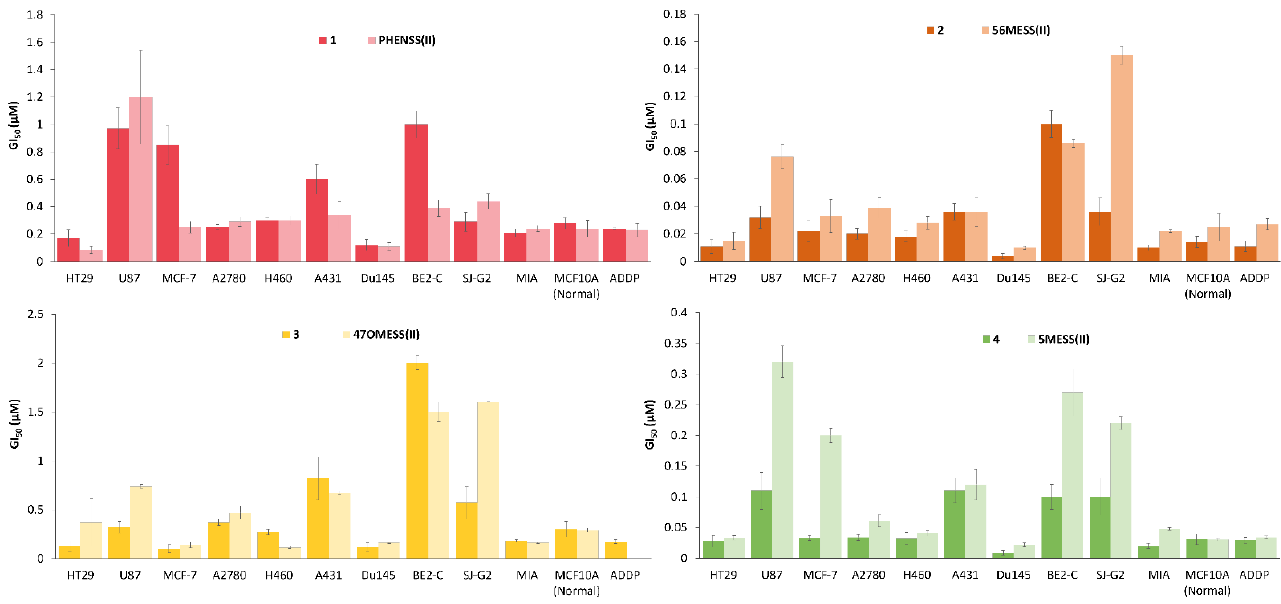
Figure 10. The GI 50 values of 1 – 4 and their platinum(II) precursors, PHENSS(II) , 56MESS(II) , 47OMESS(II), and 5MESS(II), in the cell lines tested against. The values are also listed in Table S4. 47OMESS(II) , and 5MESS(II) , in the cell lines tested against. The values are also listed in Table S4. Complexes were incubated for 72 h. GI 50 values (µM) are the mean and reported with standard error Complexes were incubated for 72 h. GI 50 values ( µ M) are the mean and reported with standard error of the mean; produced from three independent experiments. of the mean; produced from three independent